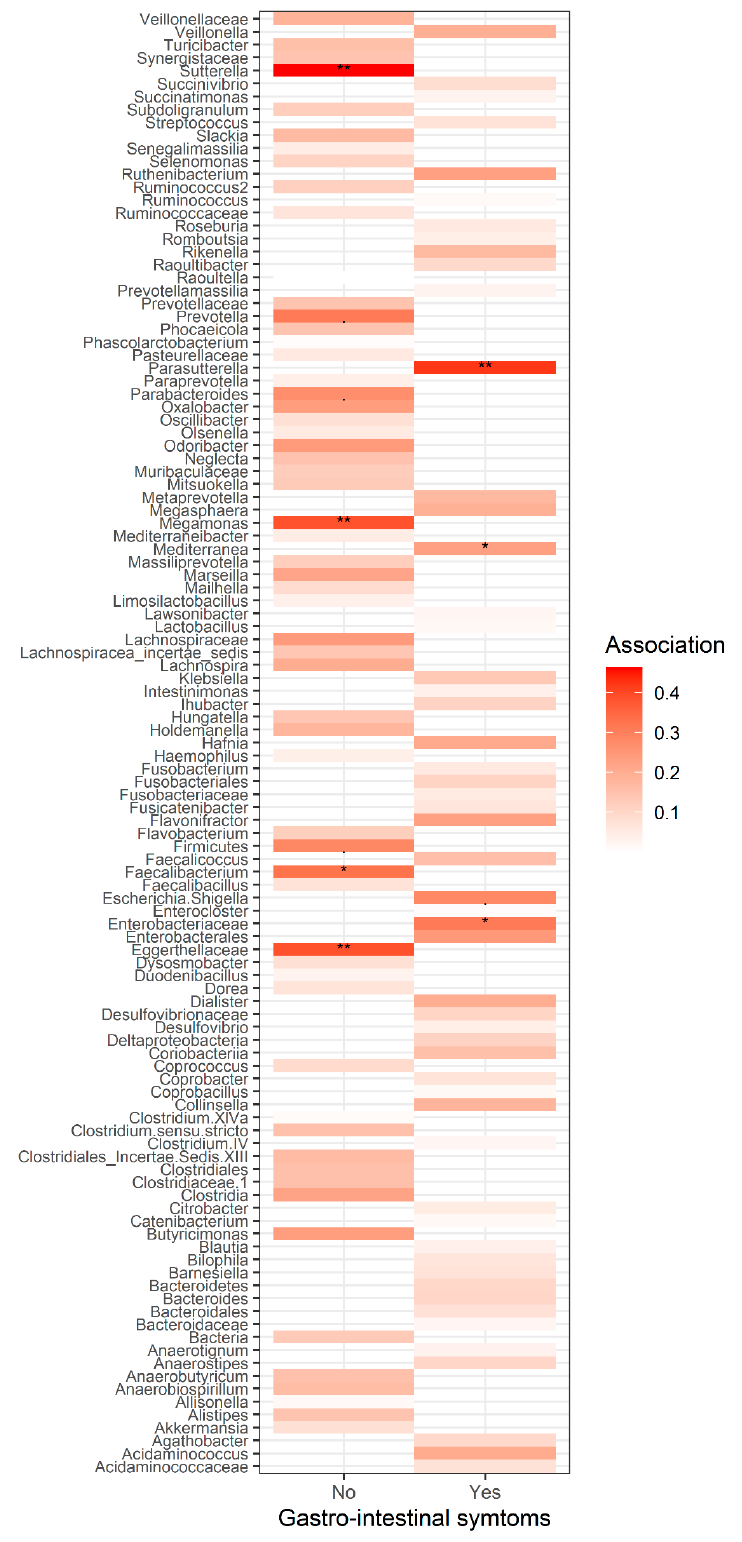
Figure 6. The most common taxa and the strength of association (and corresponding p values) with a presence/lack of gastrointestinal symptoms. * strength of association